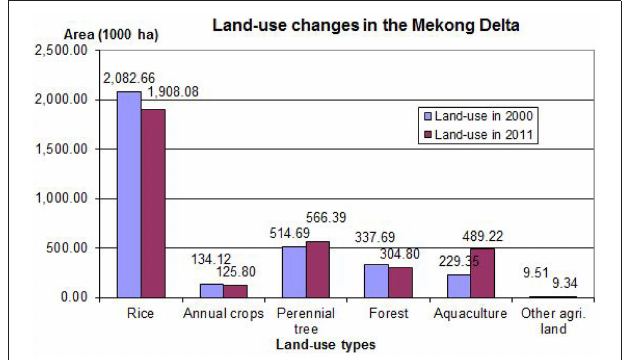
FIGURE 1 | Land-use area in the Mekong Delta in 2000 and in 2011. Source: Vietnamese General Statistics Office ( VGSO, 2000) and Ministry of Natural Resources and Environment (MONRE, 2012) of Vietnam.